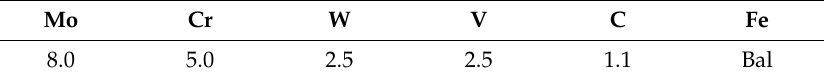
Table 2. Nominal composition of Fe-based experimental powder (wt.